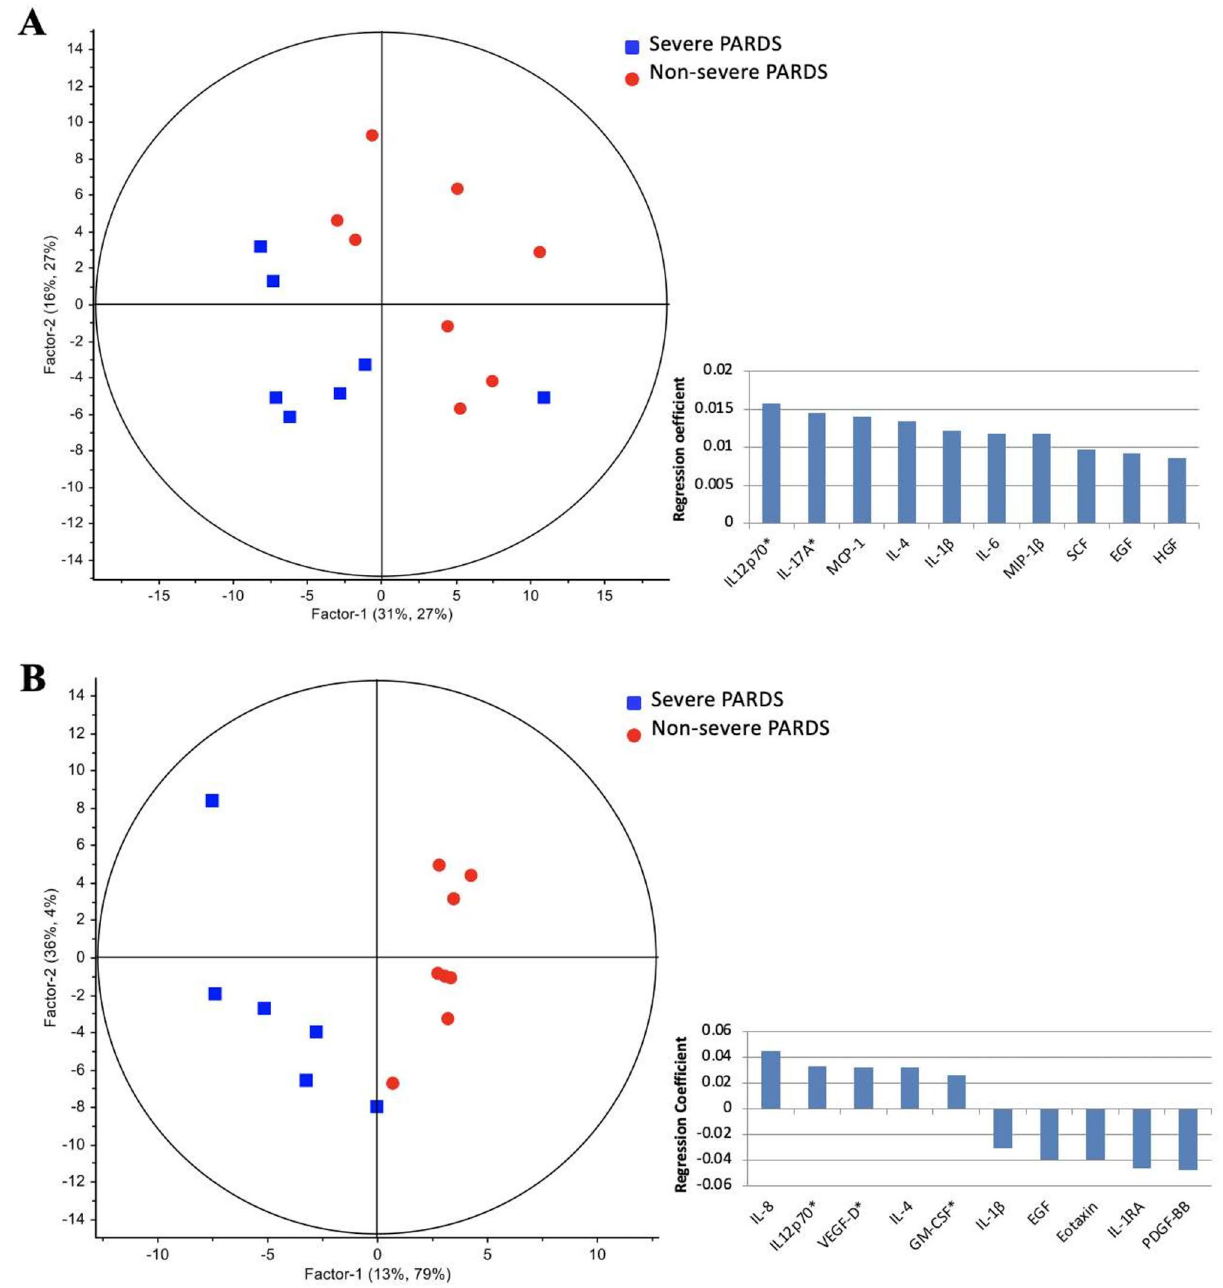
Figure 1. Respiratory cytokines showed distinct segregation between non-severe and severe PARDS in the partial least squares regression model (left) in early ( A ) and late ( B ) timepoints of disease. Regression coefficient plots identifying the top ten respiratory cytokines associated with severe PARDS (right). *Raised on both univariate and multivariate